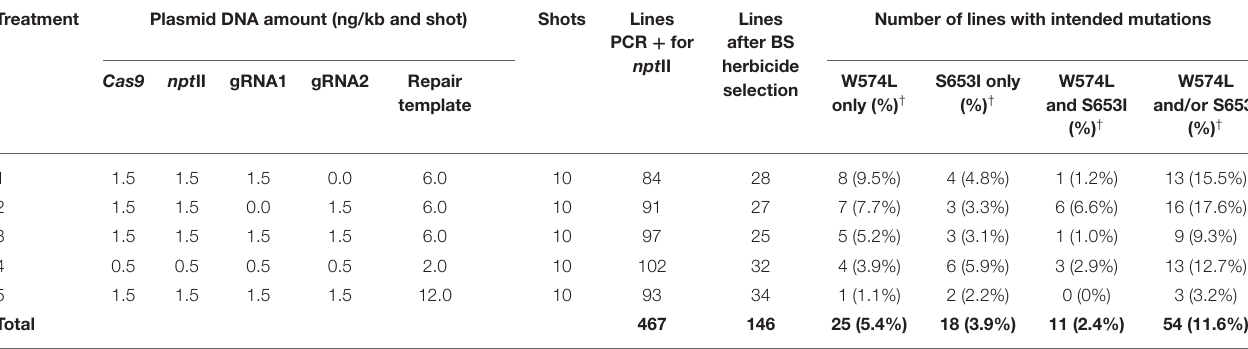
TABLE 1 | Frequency of allele replacement with homology-directed repair (HDR) following five different treatments for biolistic delivery of genome editing components. Treatment Plasmid DNA amount (ng/kb and